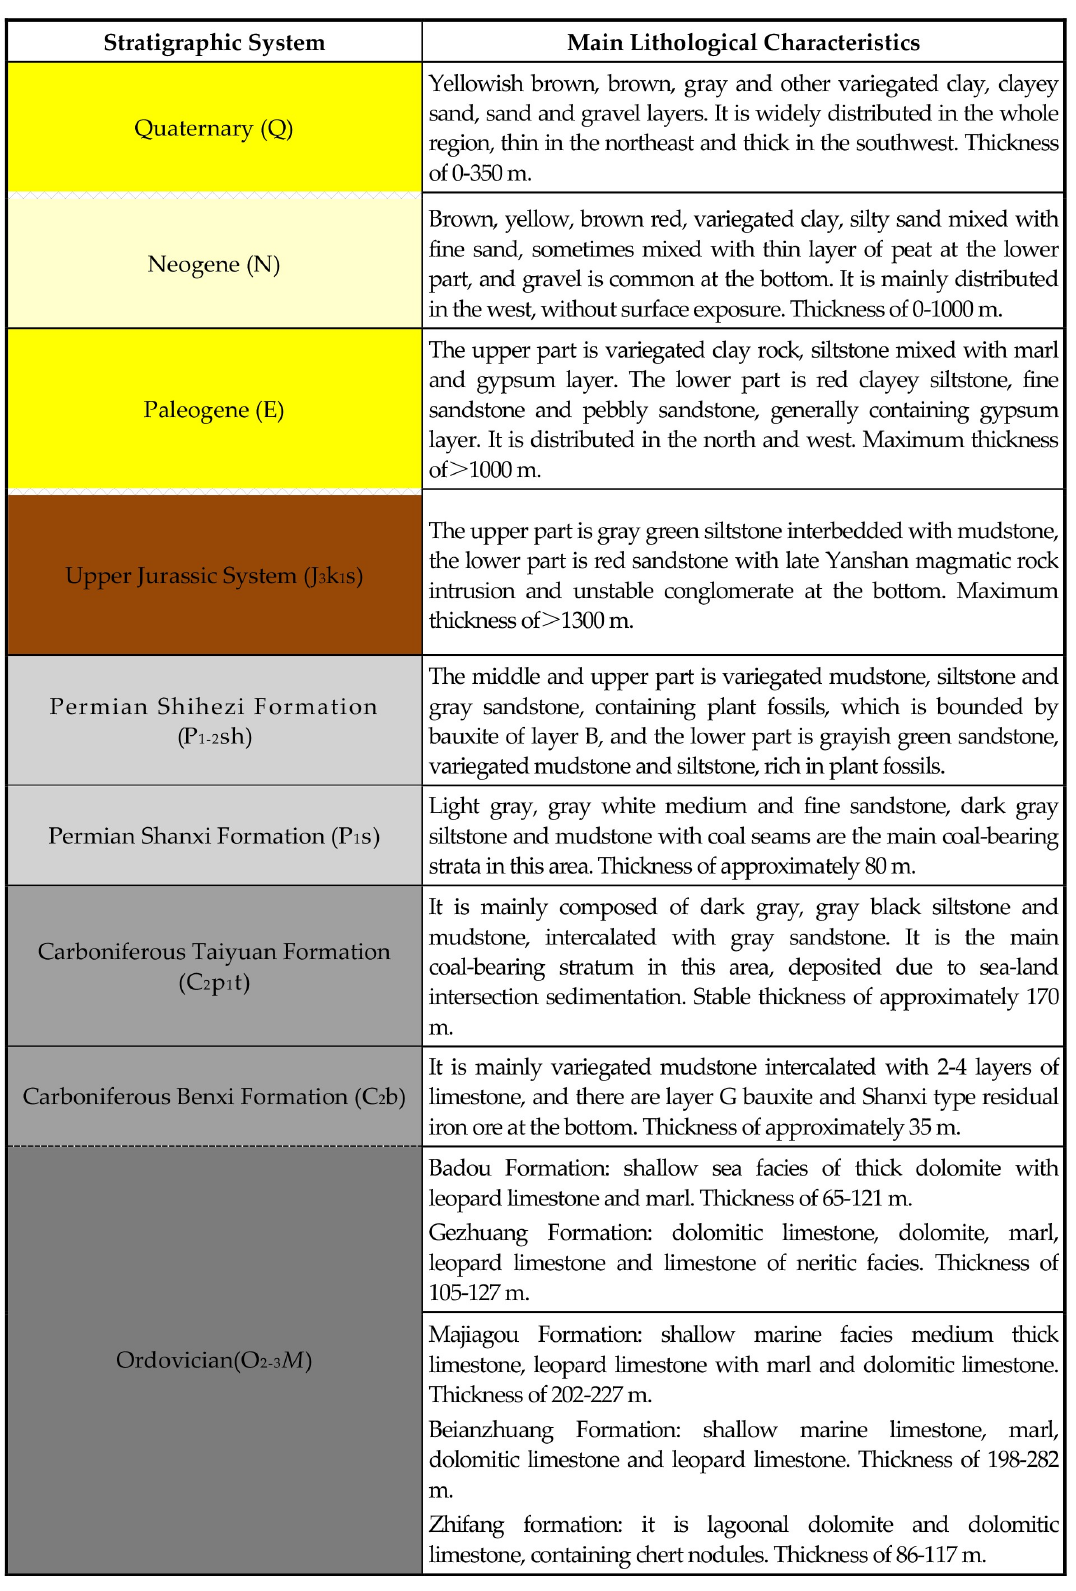
Figure A2. A brief strata list of the Southwest Shandong coalfield.